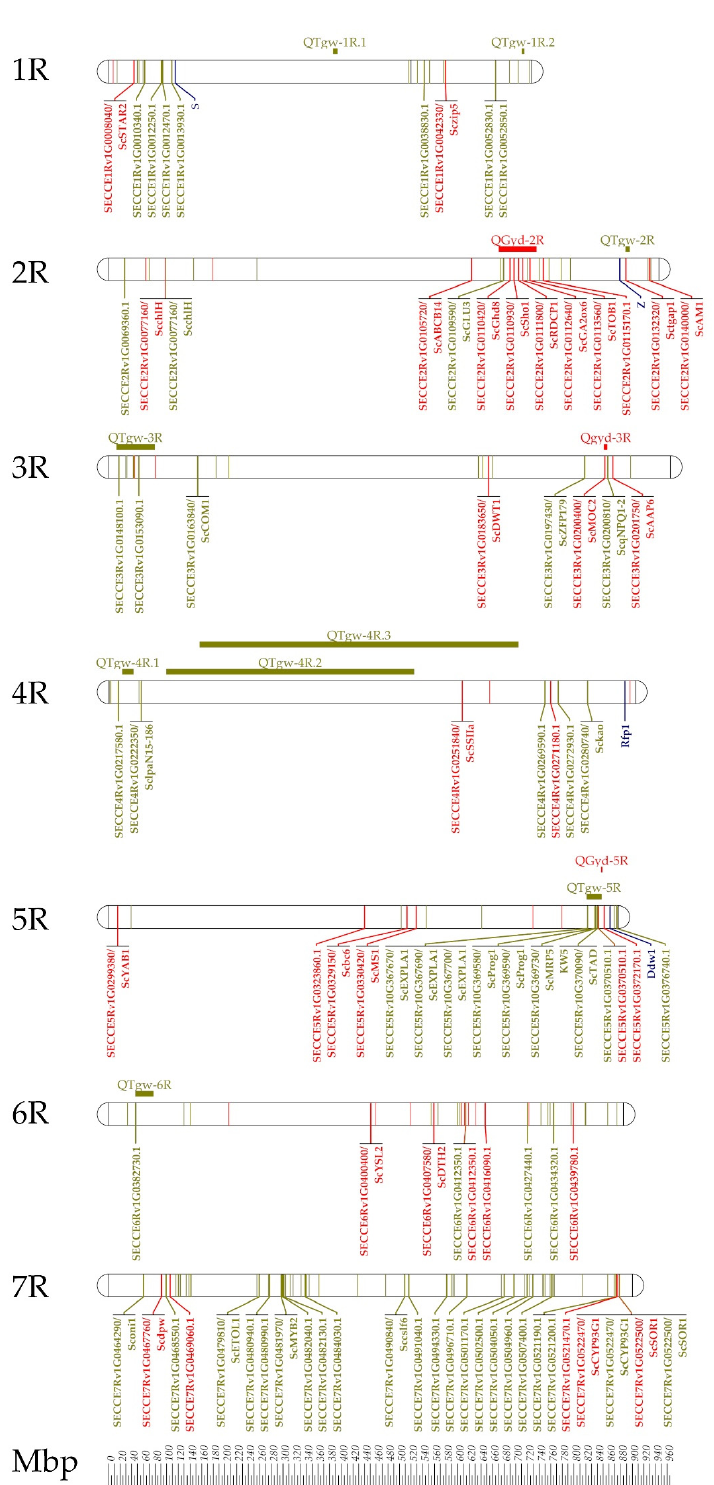
Figure 9. Physical position of cross-validated SNPs in protein coding sequences and intergenic regions of the ‘Lo7’ genome assembly detected in the GWAS for grain yield (red) and